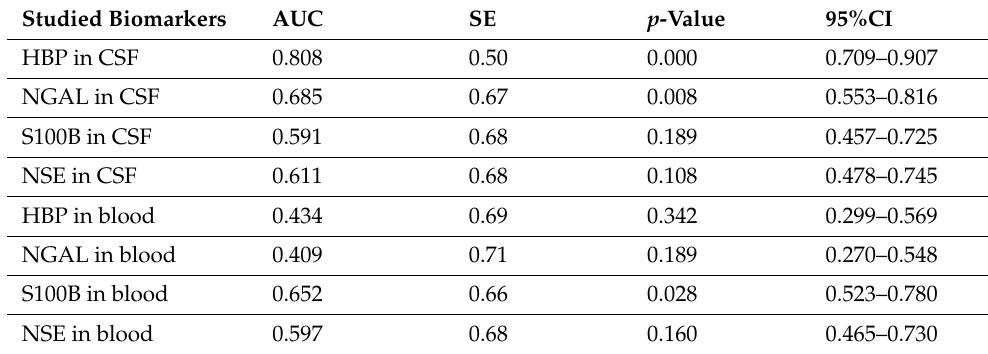
Table 6. AUC for all biomarkers (HBP, NGAL, S100B, NSE) in CSF and blood.